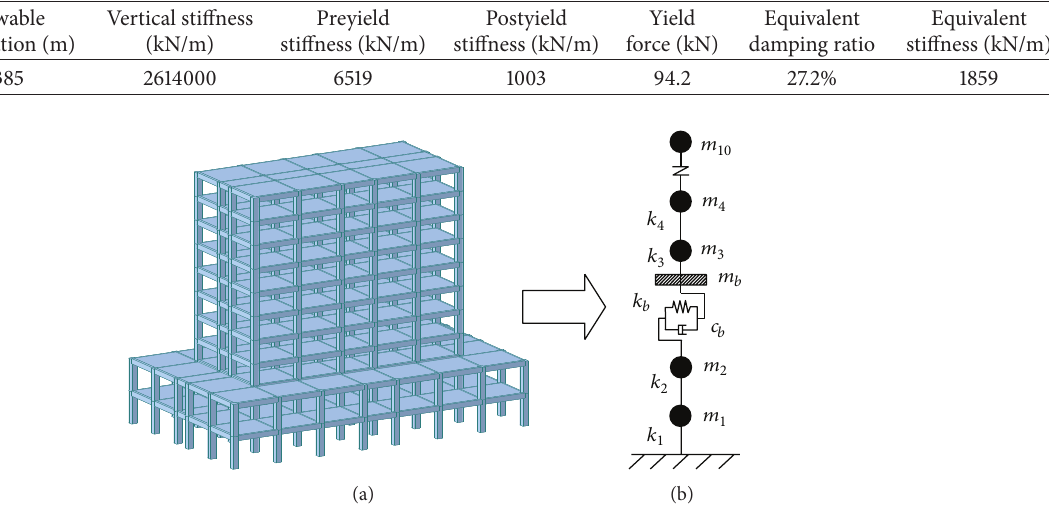
Table 1: Main characteristics of lead-rubber bearing.